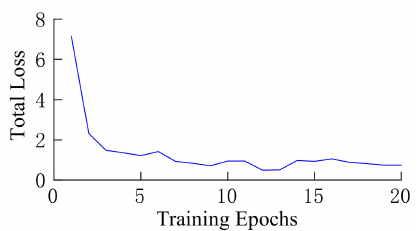
Figure 14. Loss function decline